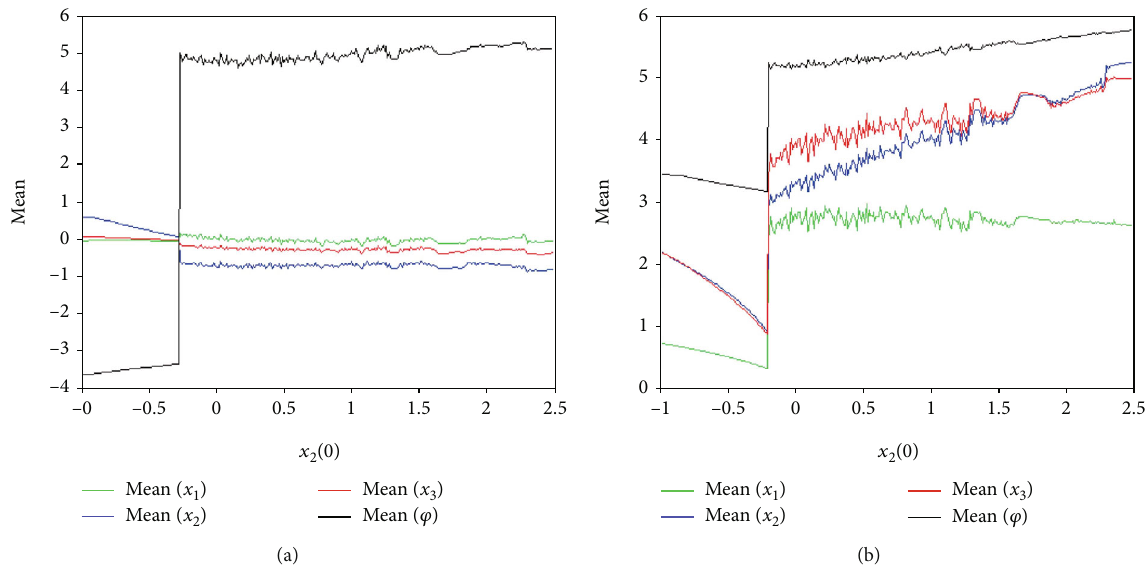
ð 0 Þ : (a) initial boosting behaviors of position induced by 2 ð 0 Þ . 2